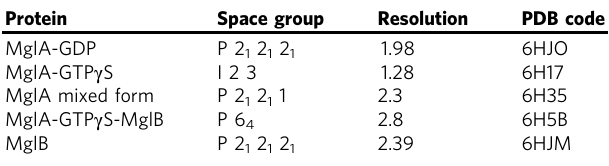
Table 1 Crystal structures determined in this study.